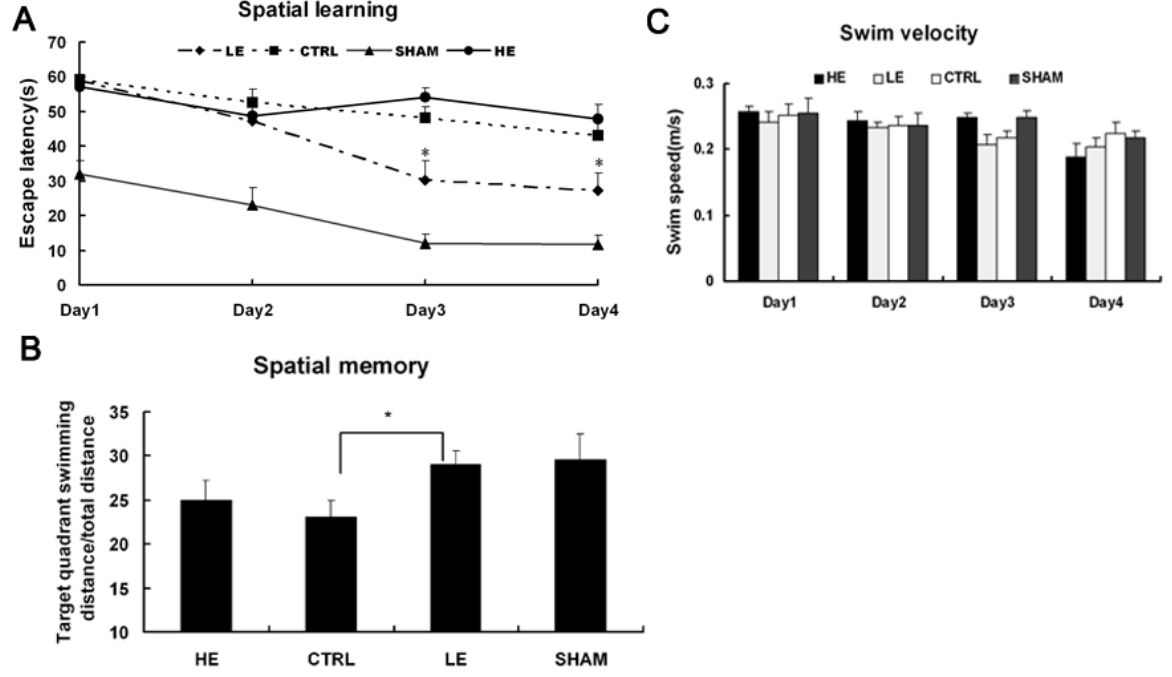
Figure 3. ( A ) The latency in the MWM task following TBI. The test began on day 21 post-injury and demonstrates that the control rats showed a significantly longer latency on days 3 and 4 of training (days 23 and 24 post-TBI, respectively) compared to the LE group ( p < 0.05). The arrival time to the platform increased in the HE exercise group compared to the control group, but this difference was not statistically significant ( p > 0.05). The data are the mean times ± standard errors of the mean (SEM). * p < 0.05 compared to the control; ( B ) A probe test was used to determine spatial memory on day 25, post-TBI. The